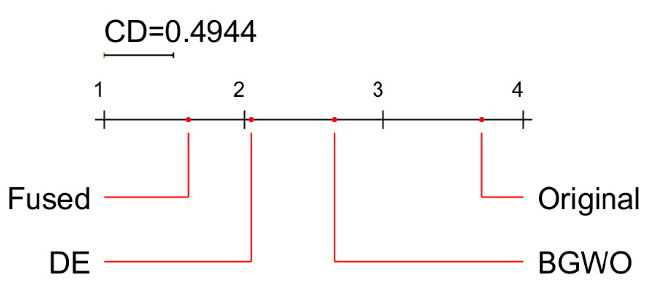
Figure 15. Critical difference diagram from the Nemenyi test: a comparison of feature selection methods ( α = 0.05).